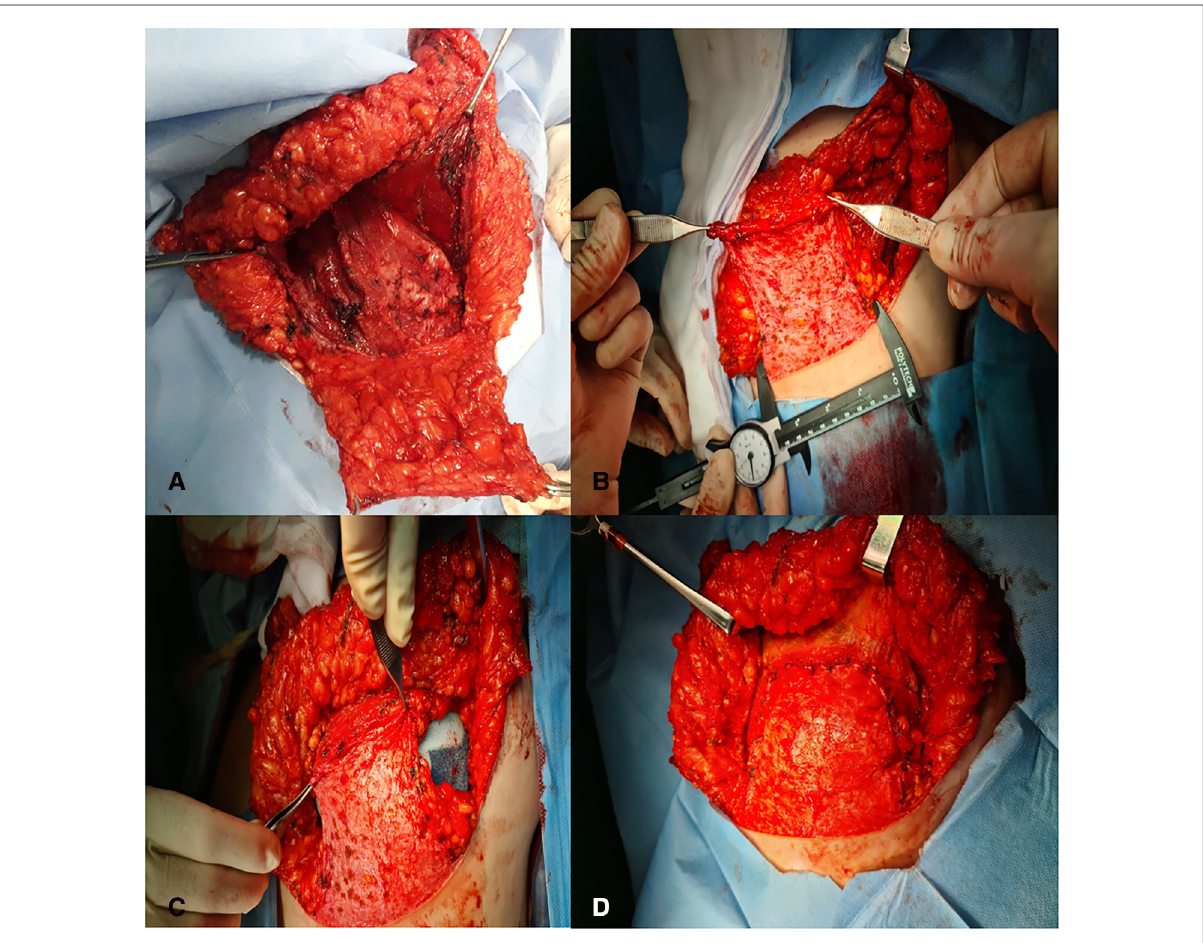
FIGURE 1 ( A,B ) Subpectoral pouch closed inferiorly and laterally by the dermal fl ap with imitated lift of the serratus anterior. ( C,D ) Tissue expander or de fi nitive prosthesis placed in the dermomuscular